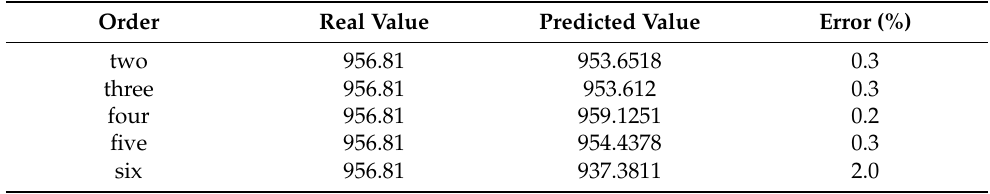
Table 6. The error of different multi-order polynomial for